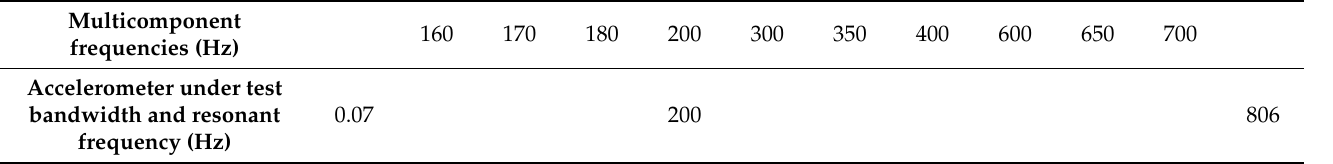
Figure 15. Test case 2, periodic signal with two harmonic components at 160 Hz and 700 Hz: comparison of the measurand with the (uncompensated) scaled instrument indication and the compensated measurement result. Short time histories ( top ) and errors for uncompensated e uc and compensated result e ( bottom ). Table 2. Test case 3. Frequencies for the multi-harmonic signal. Refer to Figure 8 and Table 1 for device under test data.